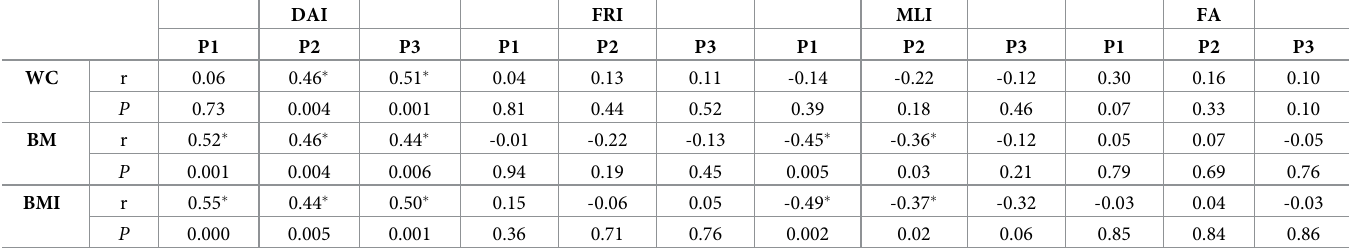
Table 3. Correlation coefficients between anthropometric data (WC, BM and BMI) and foot loading parameters (DAI, FRI, MLI and FA) in the 1 st (P1), 2 nd (P2) and 3 rd (P3) trimesters of pregnancy. DAI FRI MLI FA P1